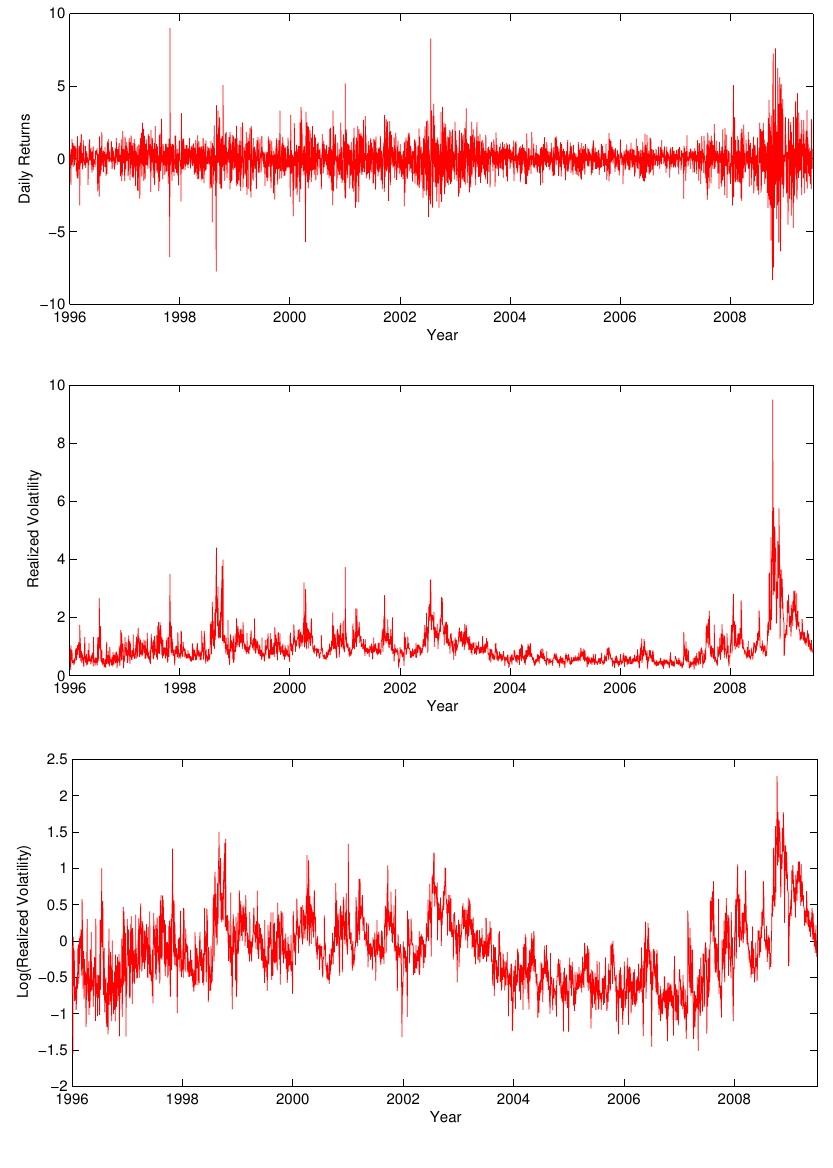
Figure 8. Time Series of returns ( top ), realized volatility ( middle ) and log realized volatility ( bottom ) for the S&P 500 index.